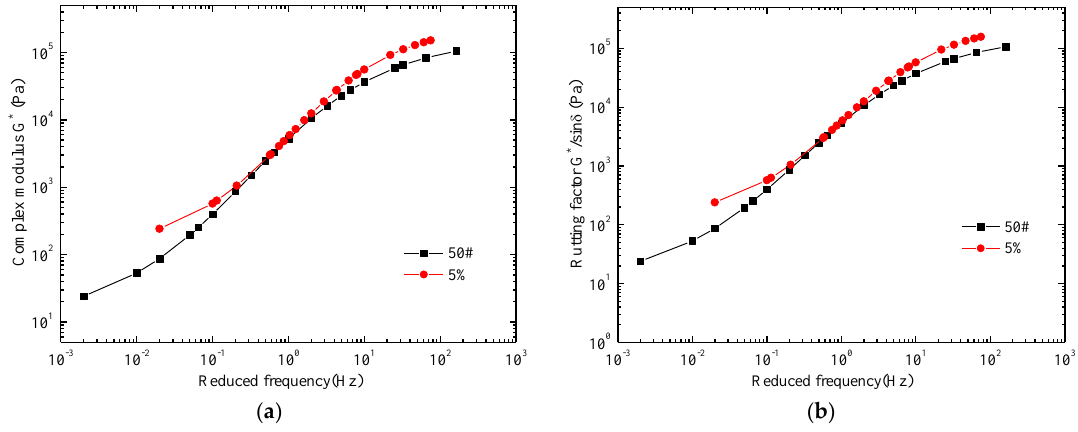
Figure 14. The changes of different parameters with reduced frequency change for the RTFO-aged asphalt. ( a ) Complex modulus; ( b ) Rutting factor.